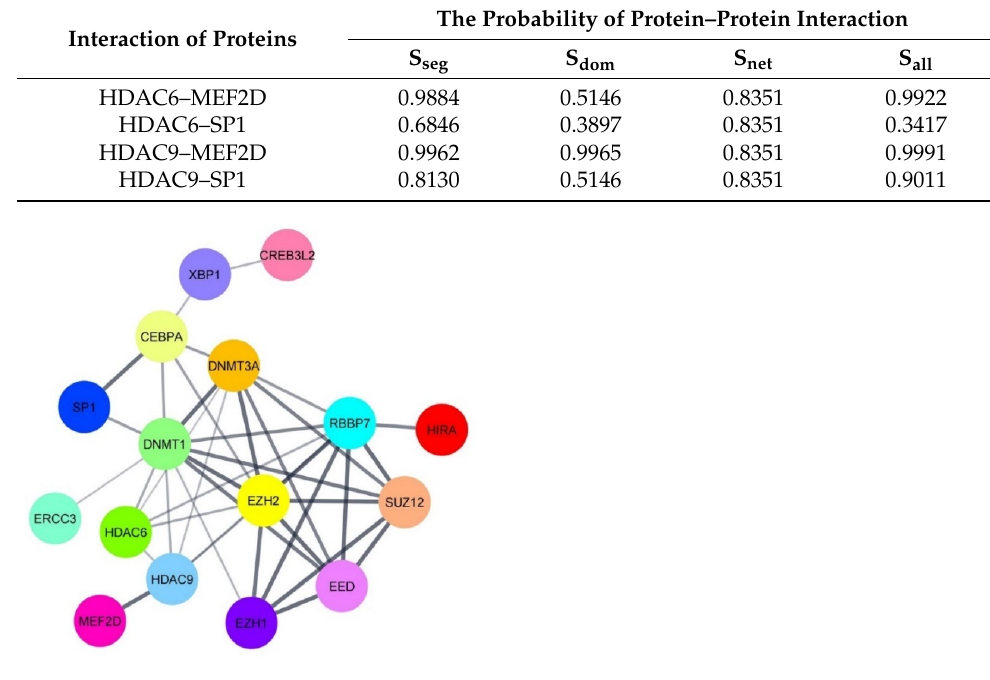
Figure 4. The PPI network of activators and suppressors of EBV lytic reactivation. The PPI network was constructed by STRING and visualized using Cystoscope software.